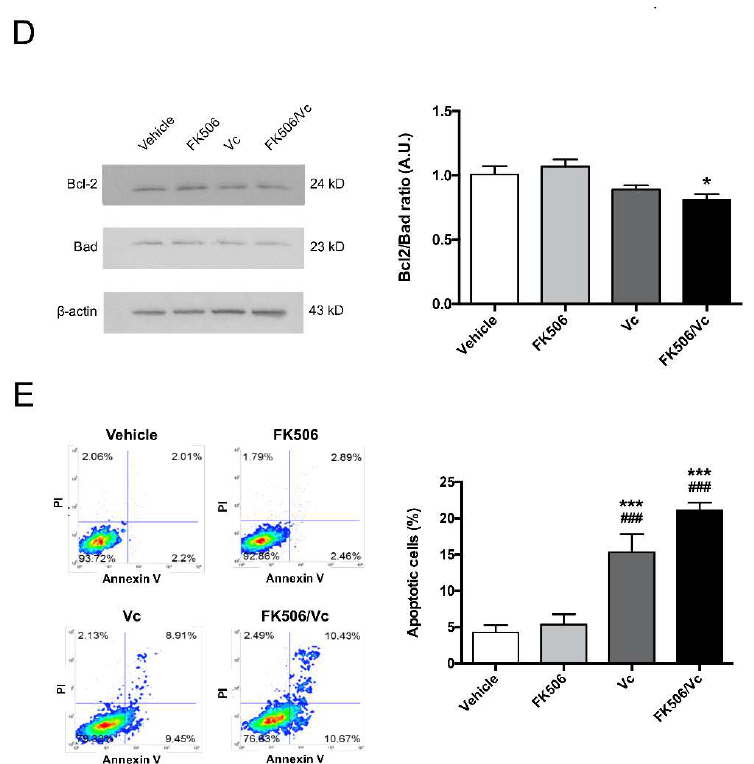
Figure 3. Vincristine in co-treatment with FK506 decreases cell viability by inducing apoptosis in U87MG and C6 cell lines. Cells were treated with FK506 (15 ng/mL) and/or Vincristine (Vc; 0,1 μM) for 24 h. Cell viability was measured by MTT assay in U87MG cells ( A ) and C6 cells ( B ). White bars represent non-GSCs and black bars represent GSCs. Apoptosis was measured by Western blot quantifying apoptotic proteins Bad/Bcl-2 ratio in U87MG GSCs ( C ) and C6 GSCs ( D ). ( E ) Flow cytometry of Annexin V and Propidium Iodide (PI) apoptotic assays in C6 cells. The graph represents the percentage of positive apoptotic cells. Graphs represent the mean ± S.D. * p < 0.05 and *** p < 0.001 versus vehicle. ### p < 0.001 versus FK506. ψψψ p < 0.001 versus Vc. n = 4.